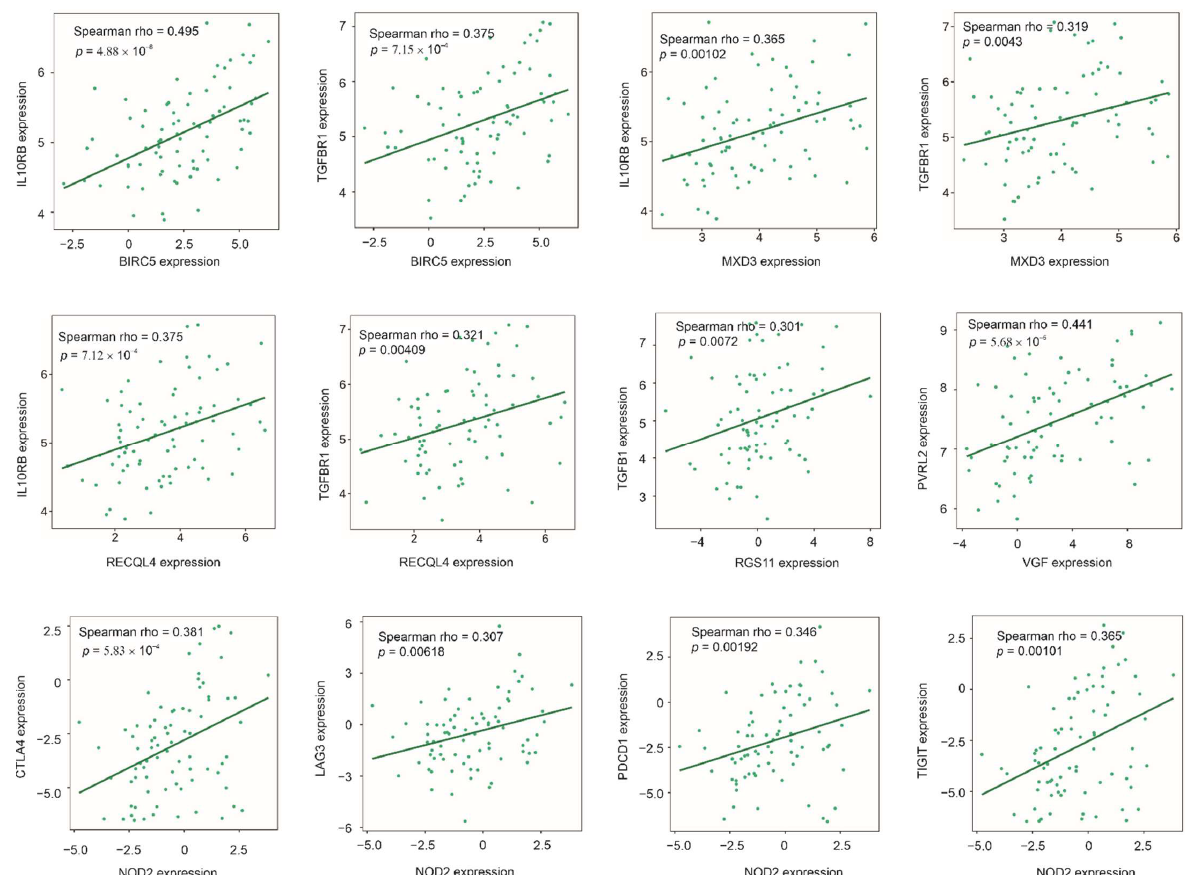
Figure 8. Correlations of the indicated signature component genes ( x axis) with the indicated immunosuppressive factors ( y axis).